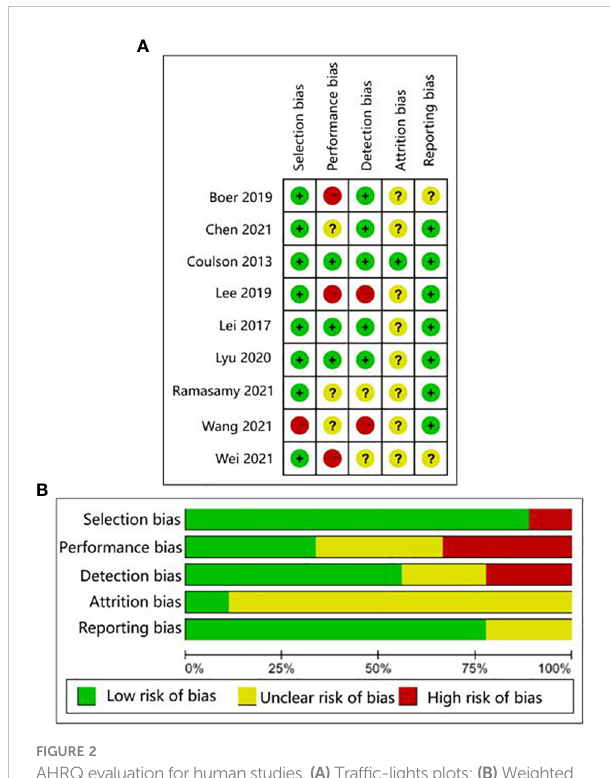
FIGURE 2 AHRQevaluationforhumanstudies. (A) Traf fi c-lightsplots; (B) Weighted